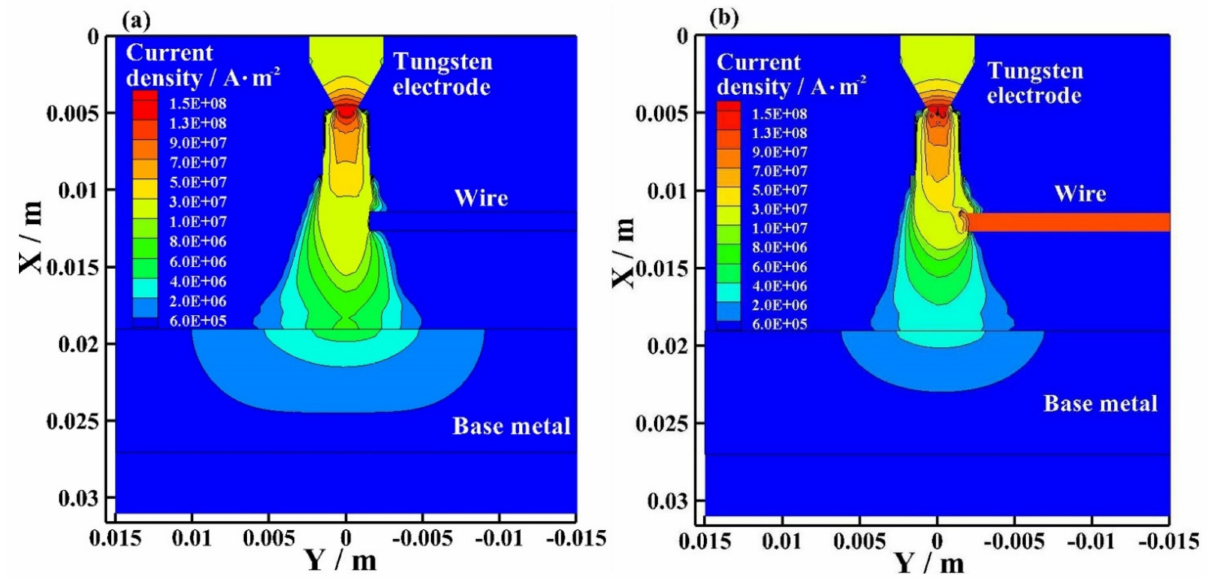
Figure 11. Current density distribution of bypass coupling arc at EN phase with and without bypass current, ( a ) 120 A and 0 A, ( b ) 60 A and 60